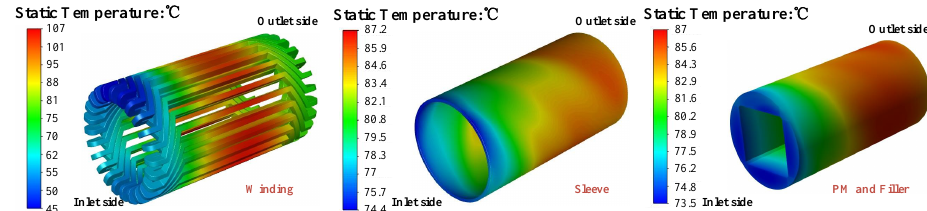
Figure 9. Temperature distribution of each part of the prototype by